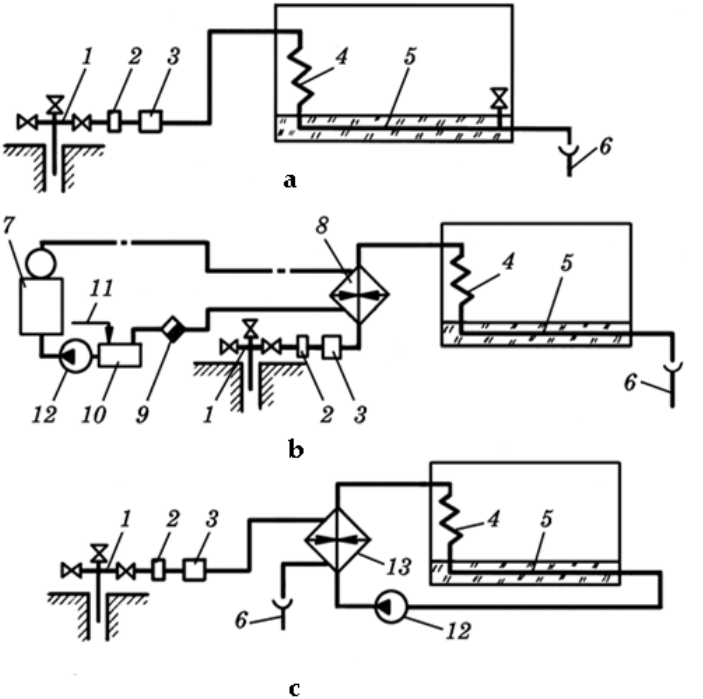
Figure 1. Heat supply schemes for greenhouses using geothermal waters: ( a )—directly; ( b )—with peak heating, ( c )—an independent circuit with a surface heat exchanger, 1—a geothermal well,